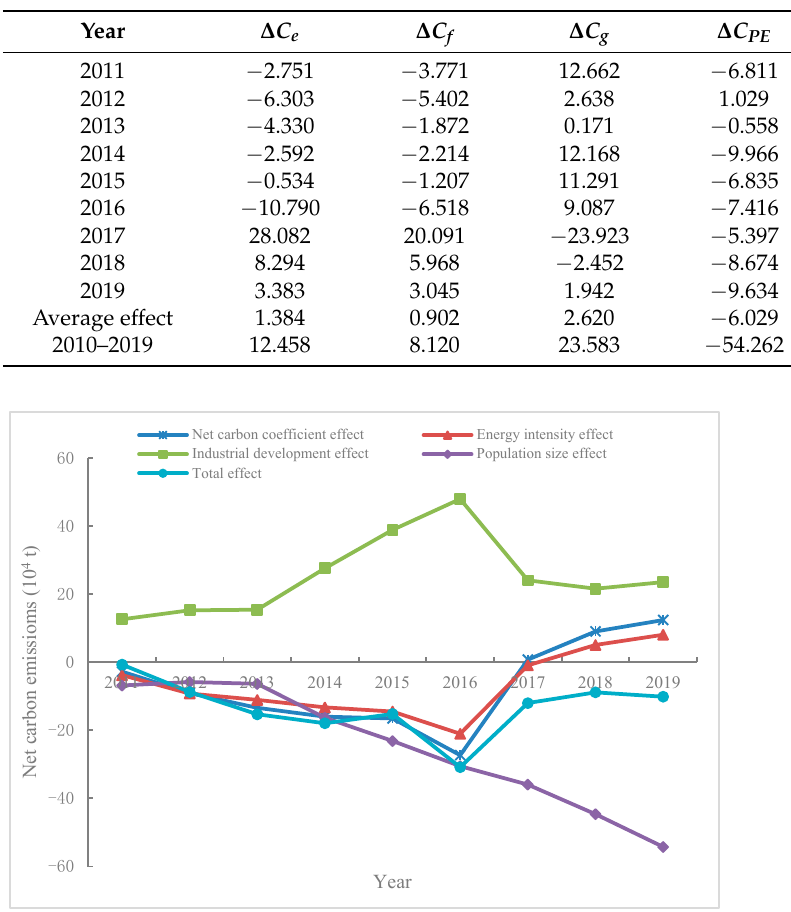
Figure 3. Cumulative effect of driving factors of net carbon emissions from China’s offshore fishing industry from 2010 to 2019.